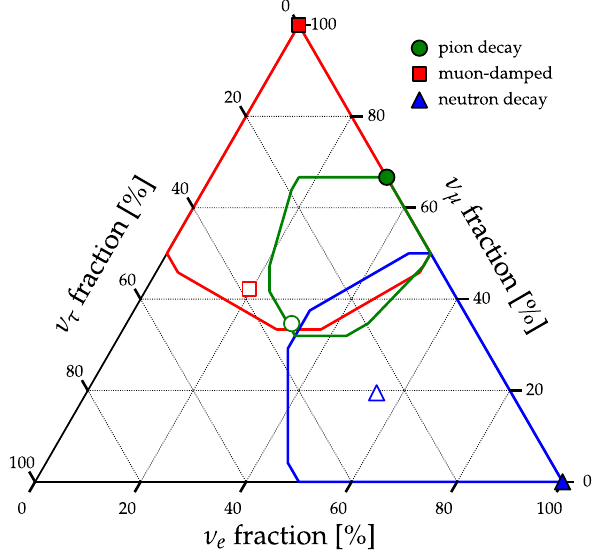
Fig. 17 The range of oscillation-averaged neutrino flavour ratios from astrophysical sources. The filled markers show the initial flavor compo- sition from pion decay (1:2:0), muon-damped pion decay (0:1:0), and neutron decay (1:0:0). The open markers show the expected observed flavour ratio assuming the best-fit oscillation parameters under the assumption of normal ordering of neutrino masses (see Table 1). The coloured contours show the range of oscillation-averaged flavor ratios based on the unitarity of the neutrino mixing matrix